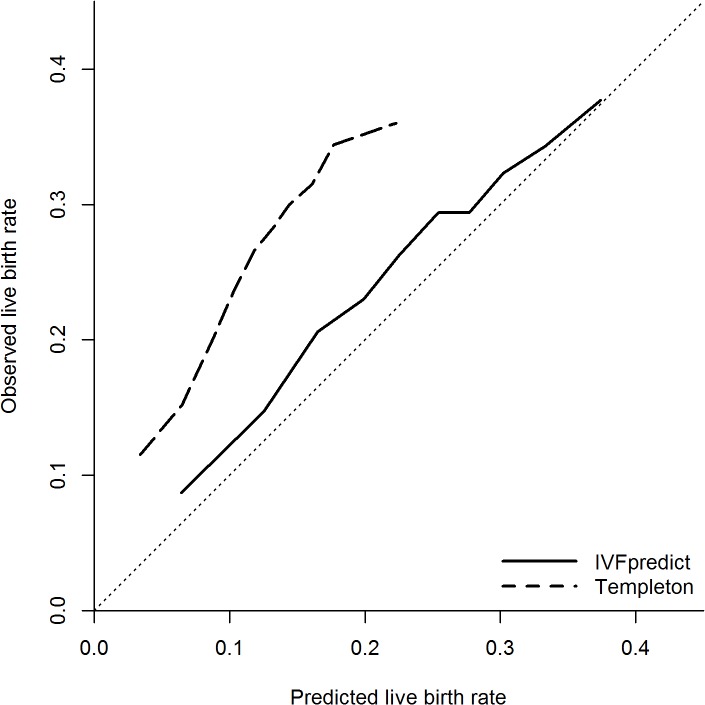
Calibration plot for the IVFpredict and Templeton models.Based on 130,960 IVF cycles. Hosmer-Lemeshow test statistics: p<0.001. Solid line, IVFpredict model; dashed line, Templeton model; dotted, diagonal line, perfect prediction (reference).